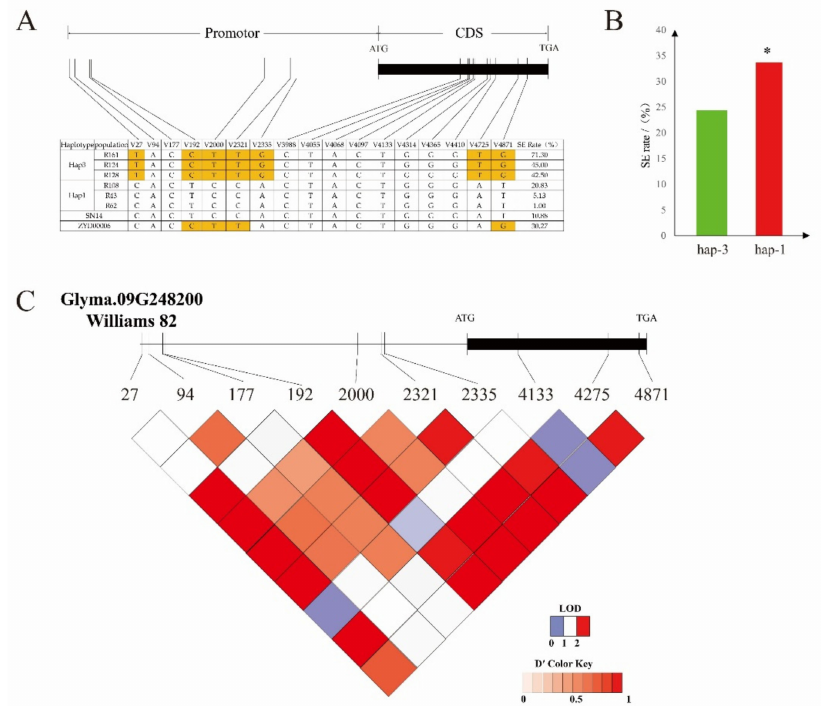
Figure 8. Haplotype analysis of the candidate gene. ( A ) Somatic embryogenesis rates of hap-1 and hap-3 (boxes colored in orange indicate di ff erences between materials). ( B ) Haplotype analysis of Glyma.09g248200 from 208 chromosome section substitution lines (CSSLs) (* denotes a significant di ff erence between hap-3 and hap-1 ( p < 0.05)). ( C ) Linkage disequilibrium analysis of single-nucleotide polymorphisms (SNPs), located in Glyma.09g248200. Red, from light to dark, represents the degree of linkage between